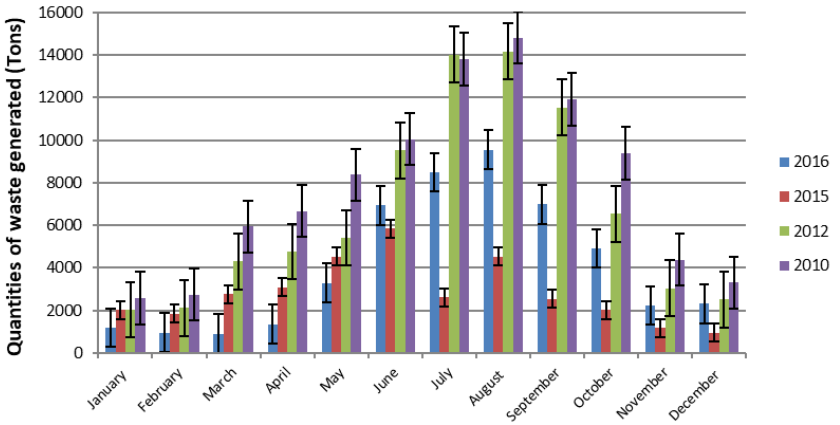
Figure 3. SW generation from accommodation establishments between 2010 and 2016 in Tunisia.